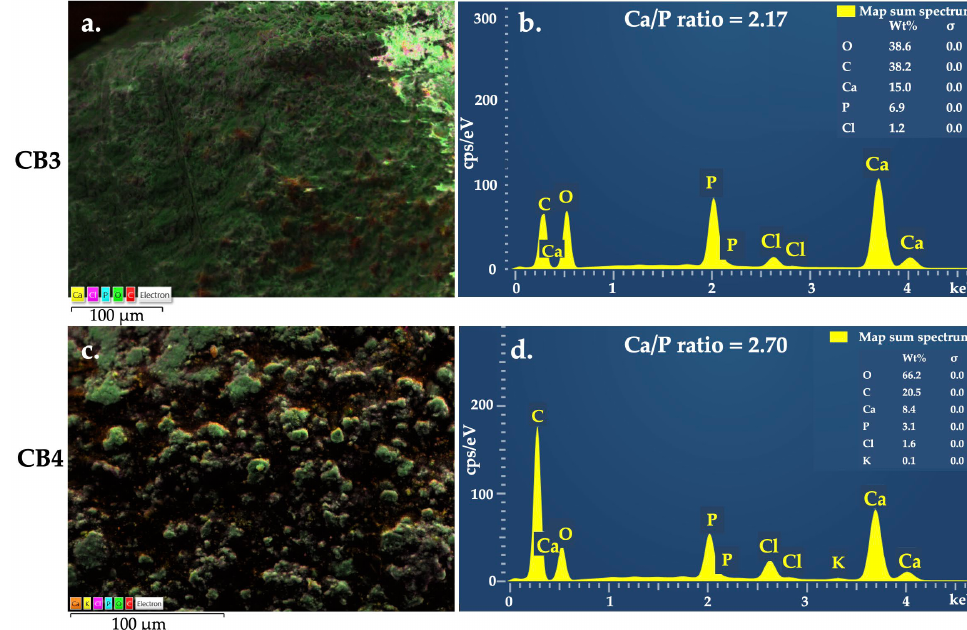
Figure 4. EDX mapping for ( a ) CB3 and ( c ) CB4 and Elemental analysis for ( b ) CB3 and ( d ) CB4.